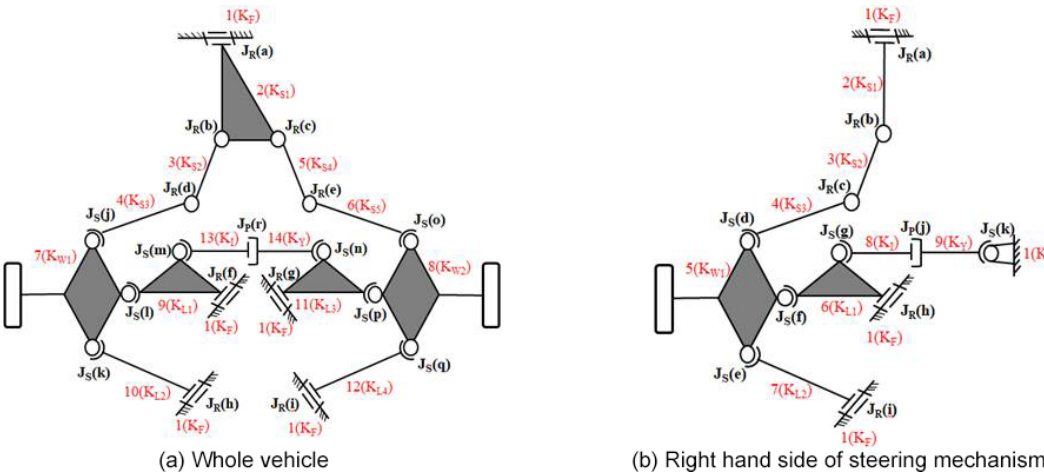
Figure 5. An existing design of the three-wheel tilting motorcycle